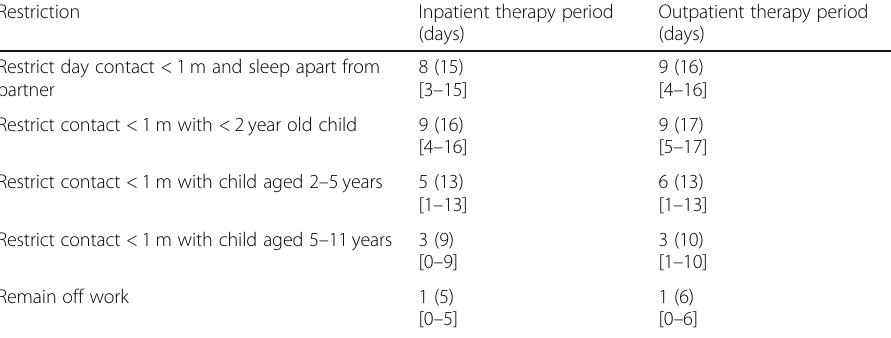
Table 5 Mean (upper 95th percentile) [range] restriction durations for inpatient and outpatient 177 Lu-DOTATATE administrations to limit dose for close relatives to 1 mSv per cycle and 0.3 mSv